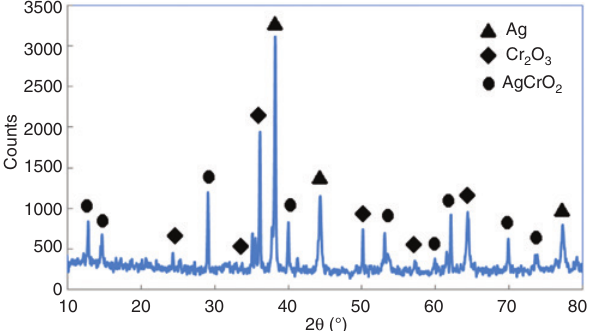
Figure 4: XRD pattern of the calcined powders.